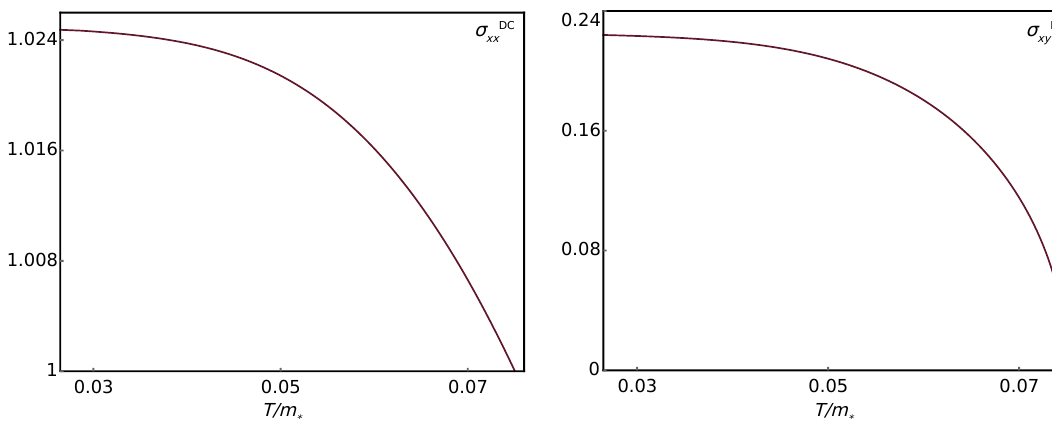
Figure 8 . DC conductivities, defined as σ DC